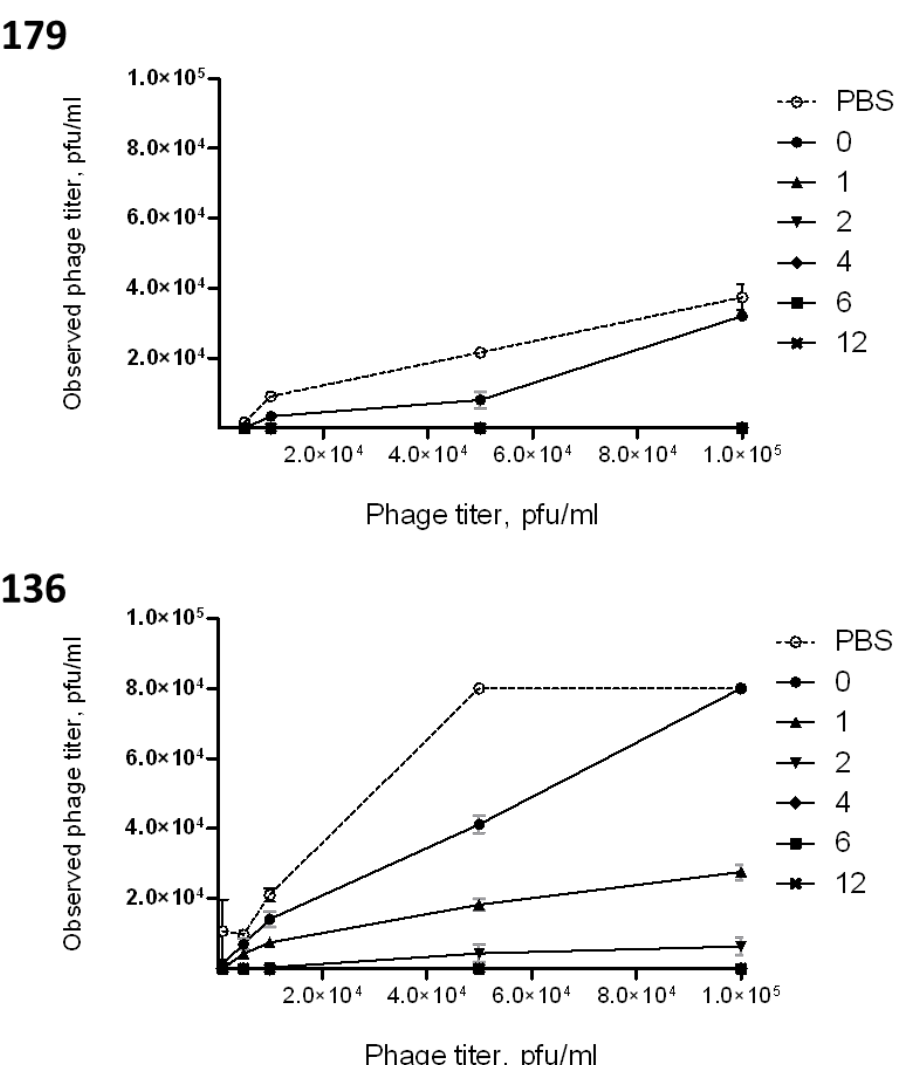
Figure 6. Neutralizing activities of pooled serum samples obtained before immunization and 1, 2, 4, 6, and 12 weeks after the last immunization of mice intraperitoneally injected three times with a selected phage (PM135, KP179, or PA136) without any adjuvants.